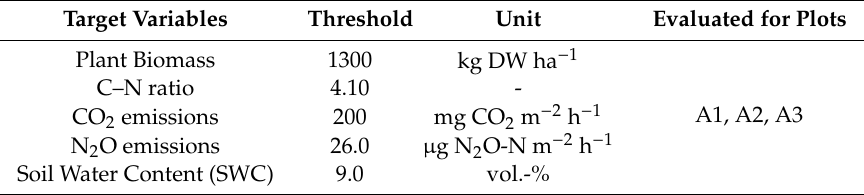
Table 1. Maximum acceptable Root Mean Squared Error (RMSE) for the target variables during model